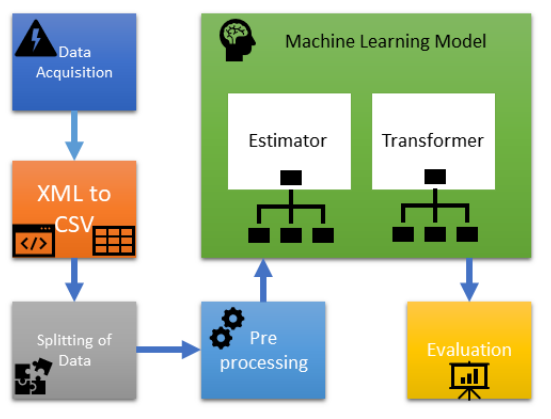
Figure 2. Process flow of energy